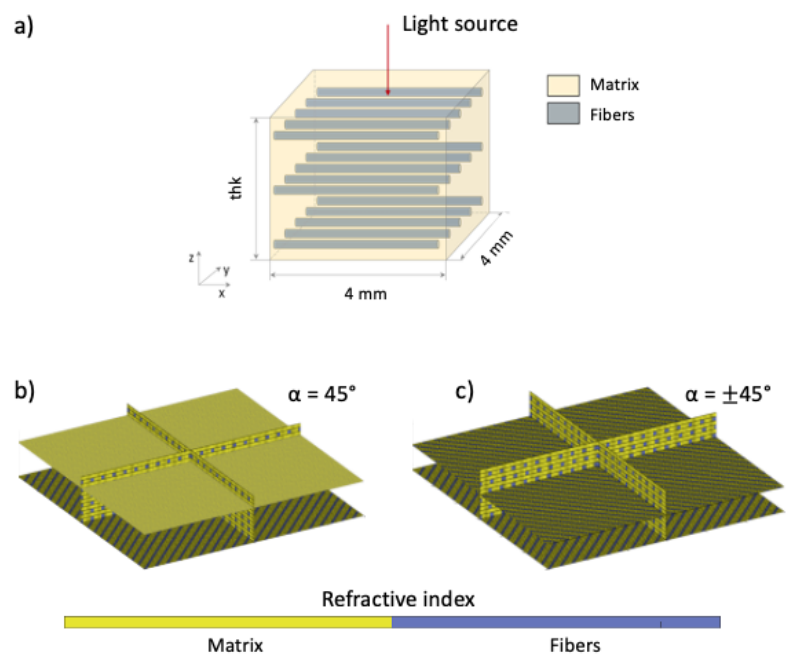
Figure 2. ( a ) Schematic for the specimen irradiation simulation, with exemplification of cases: single fiber family with ( b ) α 1 = 45 ◦ and ( c ) α 1,2 = ± 45 ◦